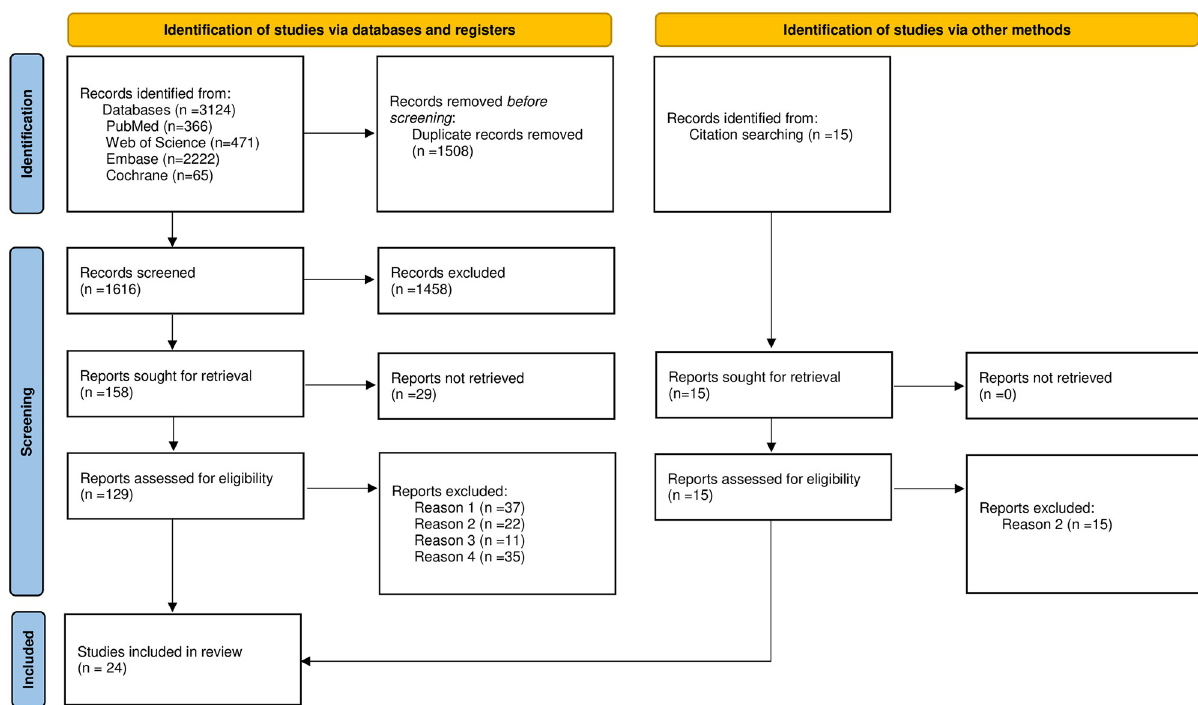
Fig 1. Preferred reporting items for systematic reviews and meta-analyses (PRISMA) flow diagram. * Reason 1; Perioperative studies, but focused on other than cognitive function. Reason 2; Reviews or Not interventional studies. Reason 3; Populations are not of interest. Reason 4; Others (Details are available in Supplemental